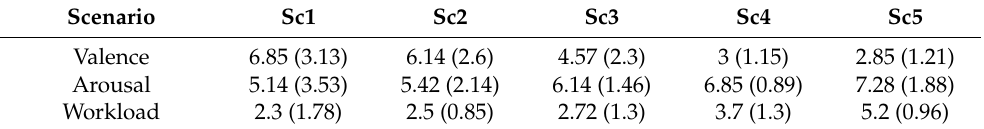
Table 3. Mean(standard deviation) of valence, arousal and workload ratings for different